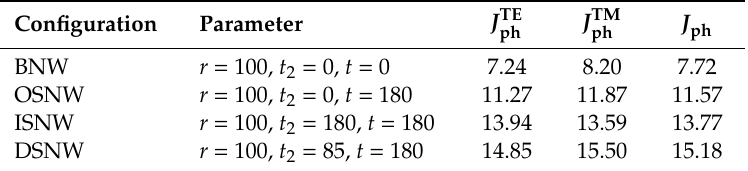
Table 1. Photocurrent densities (in mA / cm 2 ) of the four typical configurations (in nm) of the bare NW (BNW), OSNW, ISNW and DSNW under TE (Transverse electric field to the nanowire axis), TM (Transverse magnetic field to the nanowire axis) and unpolarized light illumination, where r , t 2 , and t are the core radius, the inner shell thickness and the total shell thickness,